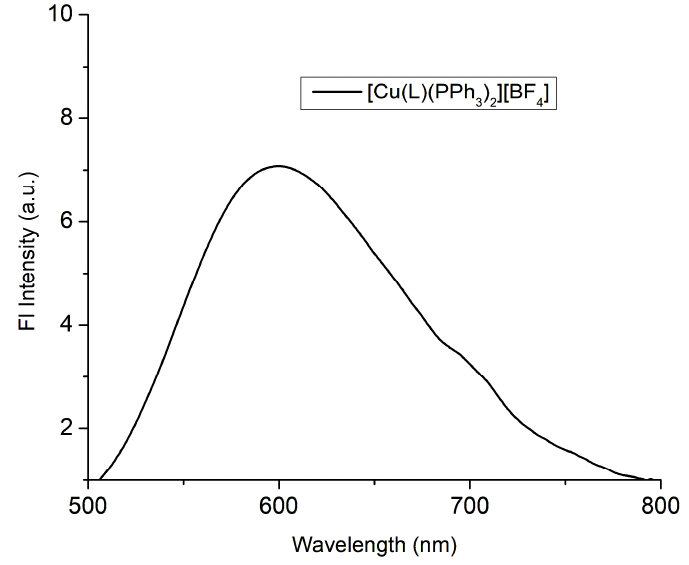
Figure 4. The emission spectrum of the solid [CuL(PPh 3 ) 2 ]BF 4 ( λ exc = 350 nm).